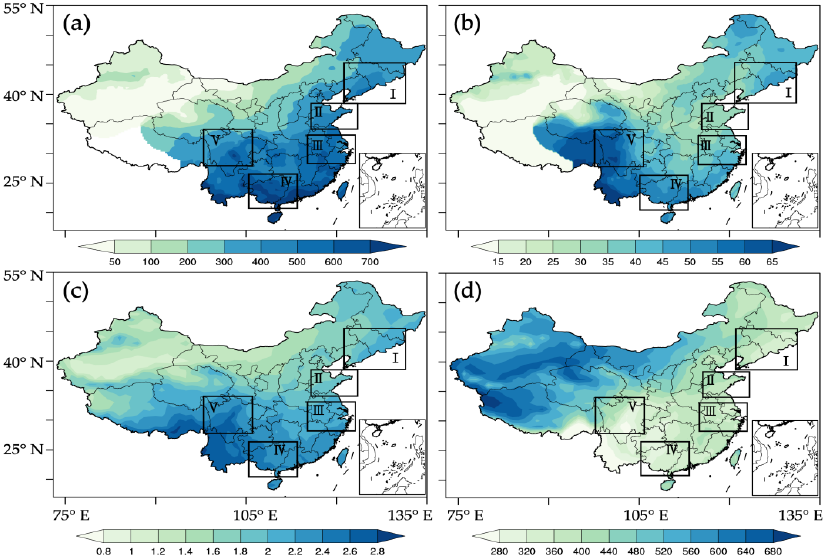
Figure 7. Spatial distribution of summer in China. ( a ) Precipitation (mm), ( b ) the number of precipitation days (days), ( c ) total cloud cover (%), ( d ) direct shortwave radiation flue (W · m − 2 ).